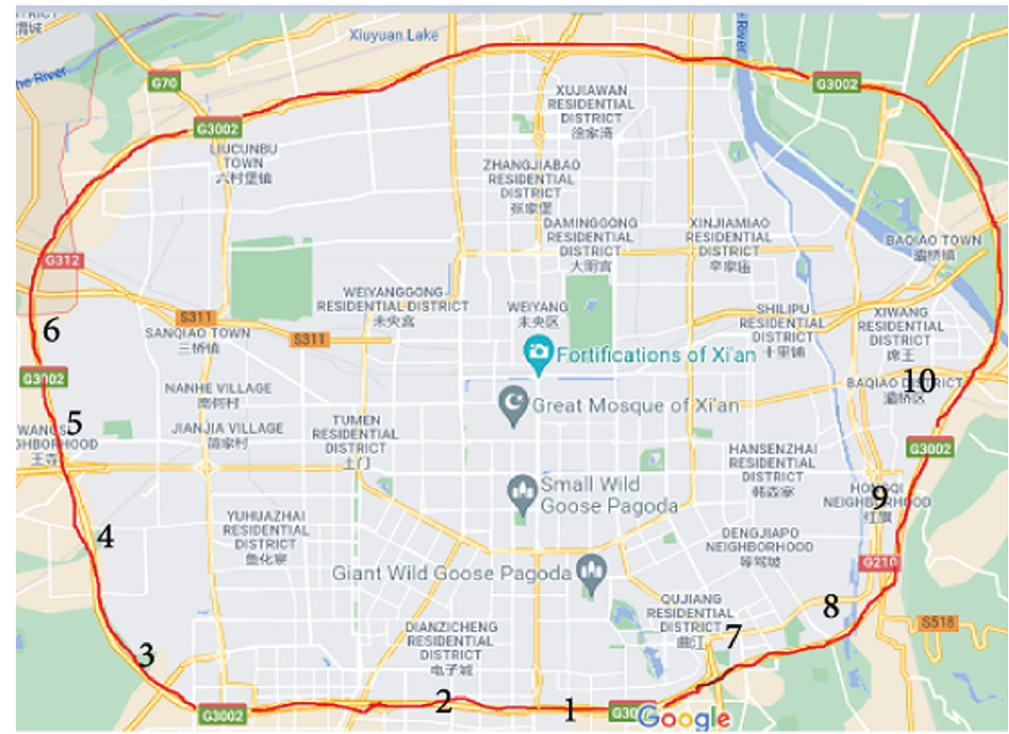
Figure 2: The Rao Cheng expressway testing Table 1: Traffic data parameters’ summary.